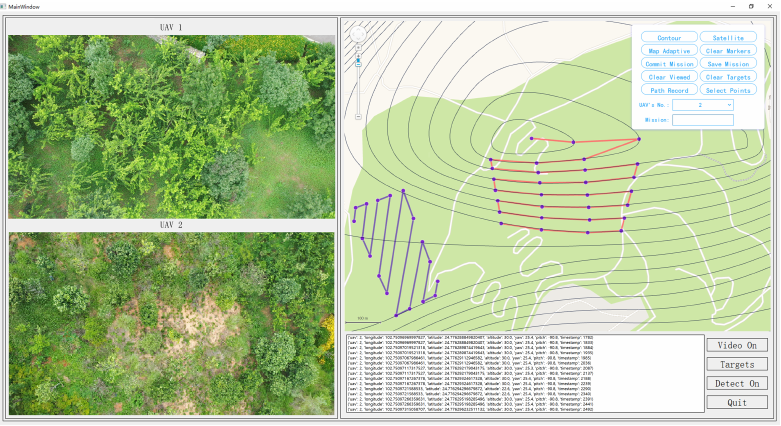
Figure 6. The multi-UAV collaboration